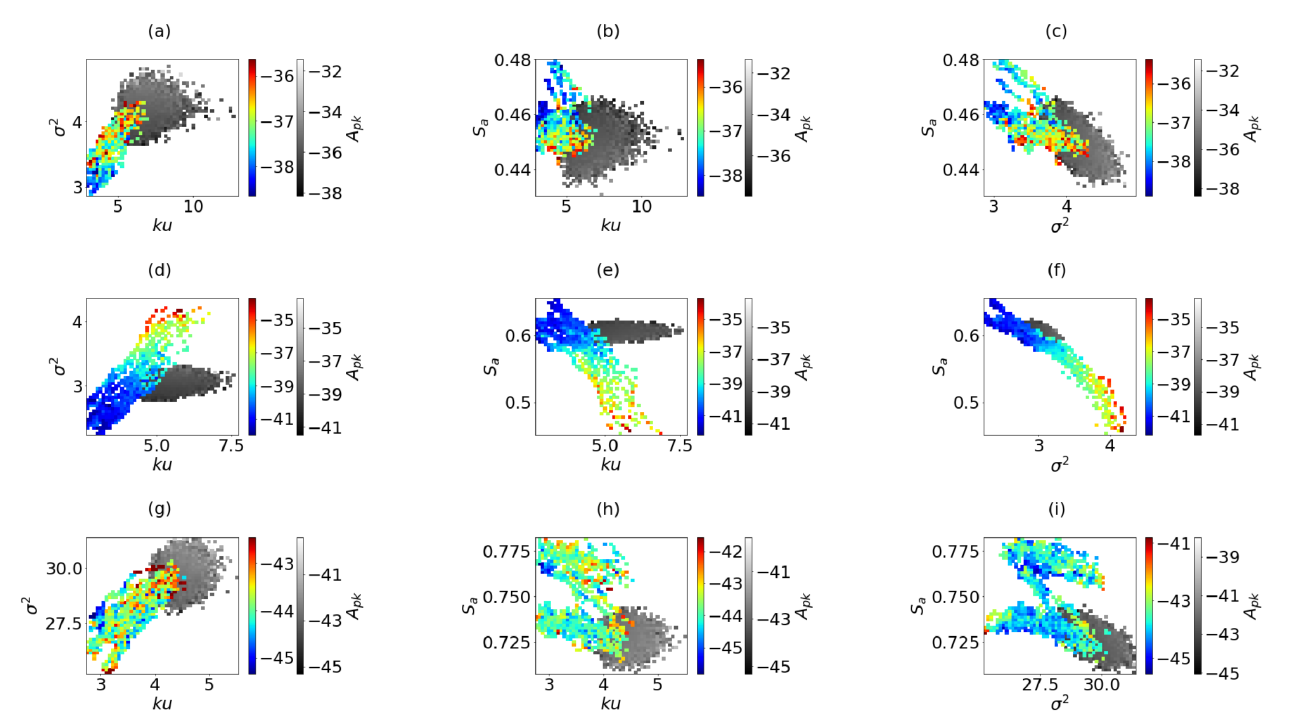
Figure 8. In color, the values of A m 5 reached by the candidates apertures in the search process. In gray, the values of A m 5 obtained with 100,000 random apertures. Configuration 100I: ( a ), σ 2 × Ku , ( b ) , S a × Ku , and ( c ) S a × σ 2 . Configuration 100V: ( d ), σ 2 × Ku , ( e ) , S a × Ku , and ( f ) S a × σ 2 . Configuration 196I: ( g ), σ 2 × Ku , ( h ) , S a × Ku , and ( i ) S a × σ 2 for configuration